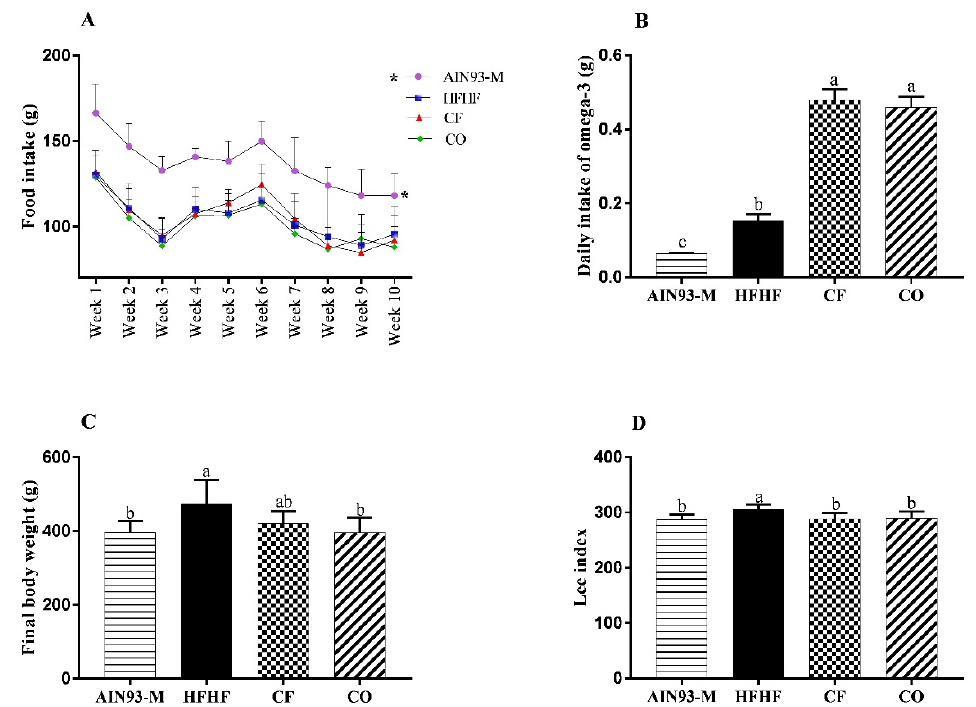
Figure 3. ( A ) Food intake (weekly); ( B ) Daily intake of omega-3; ( C ) Final body weight at the end of 10